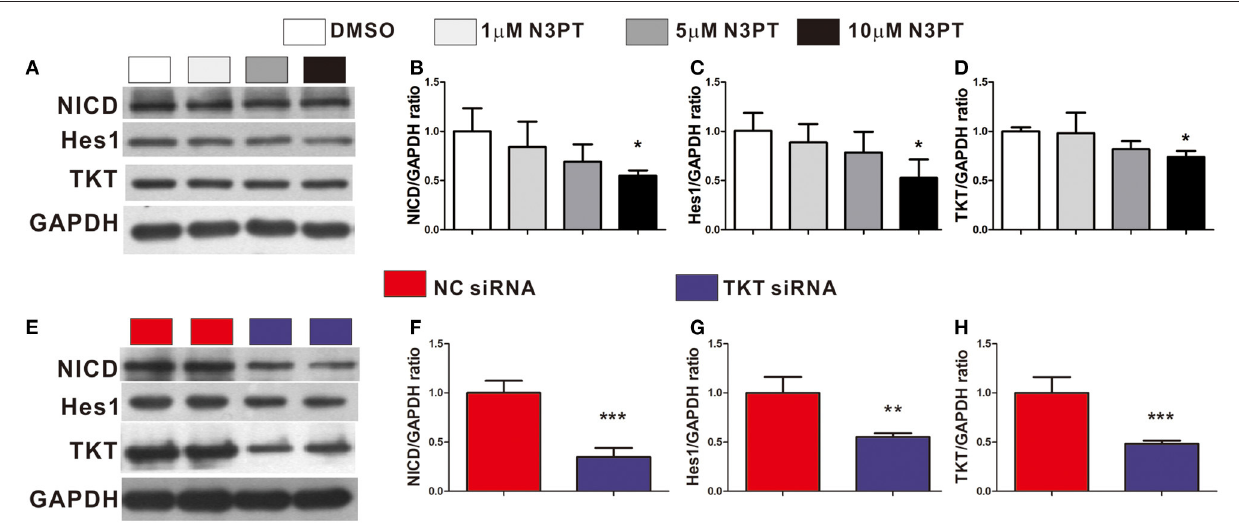
FIGURE 7 | Inhibition of TKT blocks Notch signaling pathway. (A–D) HCT116 cells were treated with DMSO or the TKT inhibitor N3PT (1, 5, or 10 µ M) for 24h. Then the protein levels in cell lysates were quantified by Western blot (A) . The quantized data indicated that 10 µ M N3PT treatment reduced the protein levels of NICD (B) , Hes1 (C) , and TKT (D) compared with the control. However, lower concentrations of N3PT had no significant effect on the protein levels of NICD, Hes1, and TKT (A–D) . (E,F) HCT116 cells were transfected with TKT siRNA or negative control (NC siRNA) for 72h. Then the protein levels in cell lysates were quantified by Western blot (E) . Cells transfected with TKT siRNA presented lower protein levels of NICD (F) , Hes1 (G) , and TKT (H) than NC siRNA transfected cells. N = 3/group, * P < 0.05, ** P < 0.01, *** P < 0.001 vs. the control group.